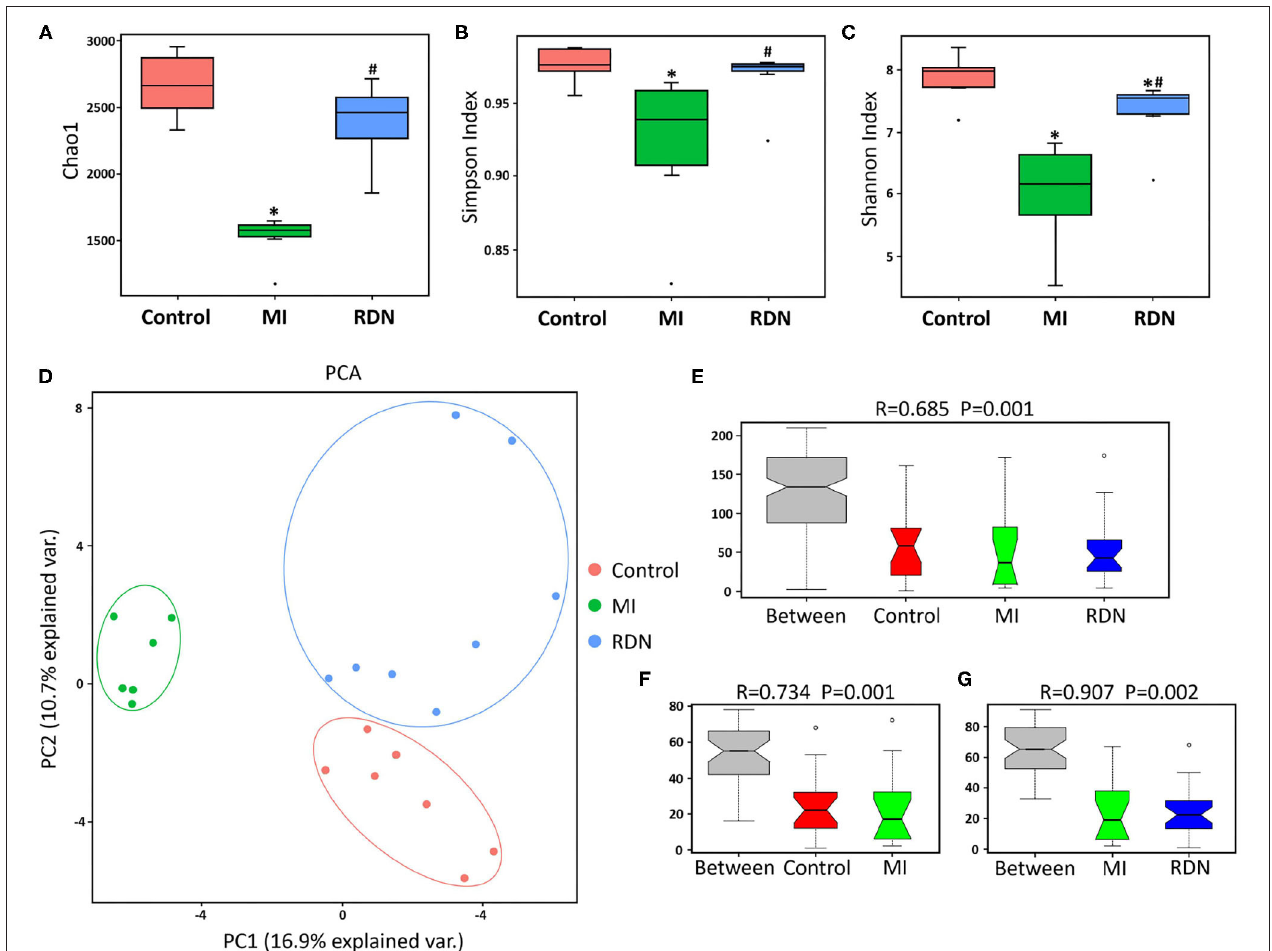
FIGURE 3 | RDN mitigates gut microbiota dysbiosis in MI rats. (A) The Chao 1 richness in different groups. (B) The Simpson diversity in different groups. (C) The Shannon diversity in different groups. (D) Principal component analysis of the similarity of microbial communities among these groups. (E) ANOSIM analysis of P and R values indicates the difference in microbial community structure between groups. (F) ANOSIM analysis of P and R values indicates the difference in microbial community structure between the Control and MI groups. (G) ANOSIM analysis of P and R values indicates the difference in microbial community structure between the MI and RDN groups. * P < 0.05 vs. the Control group; # P < 0.05 vs. the MI group.